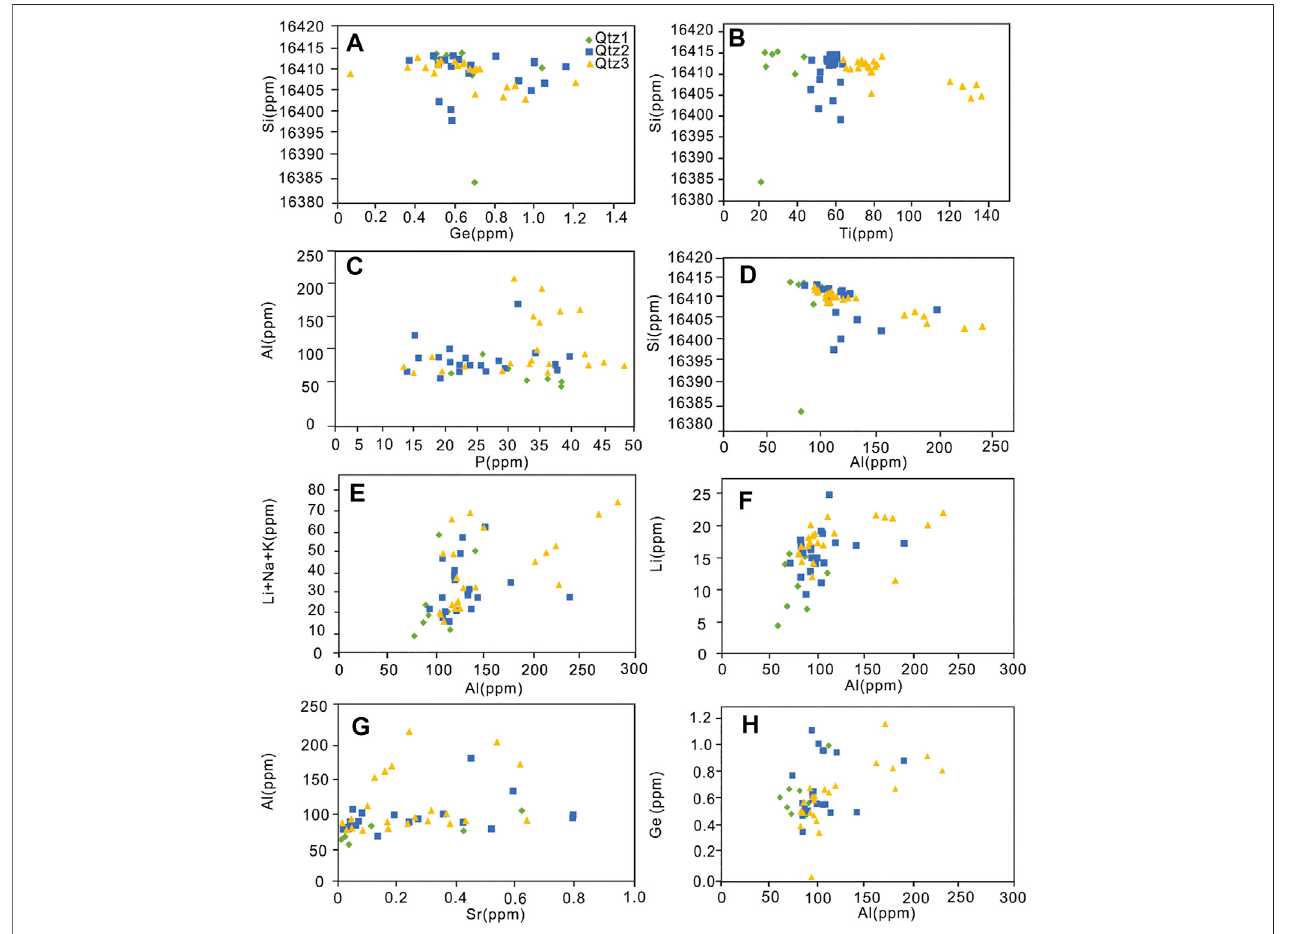
FIGURE 8 | Plots of minor and trace elements in quartz from the Hongniu-Hongshan deposit.